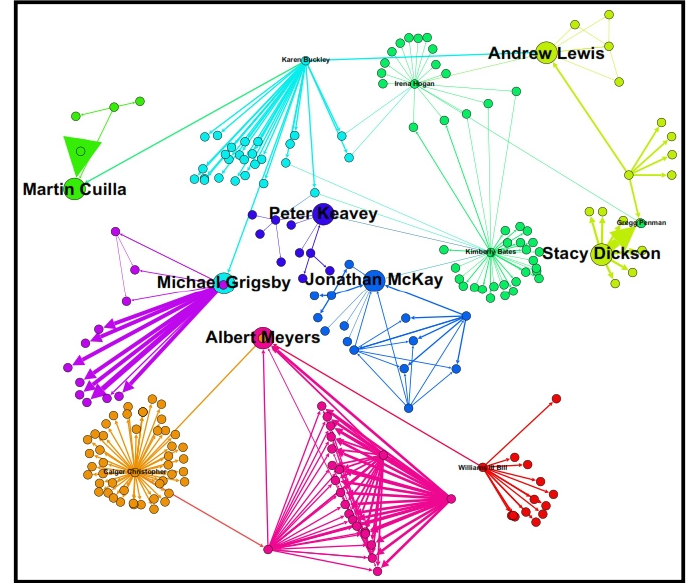
Figure 3. A reduced social network depicting email flow from group leaders in a number of groups in